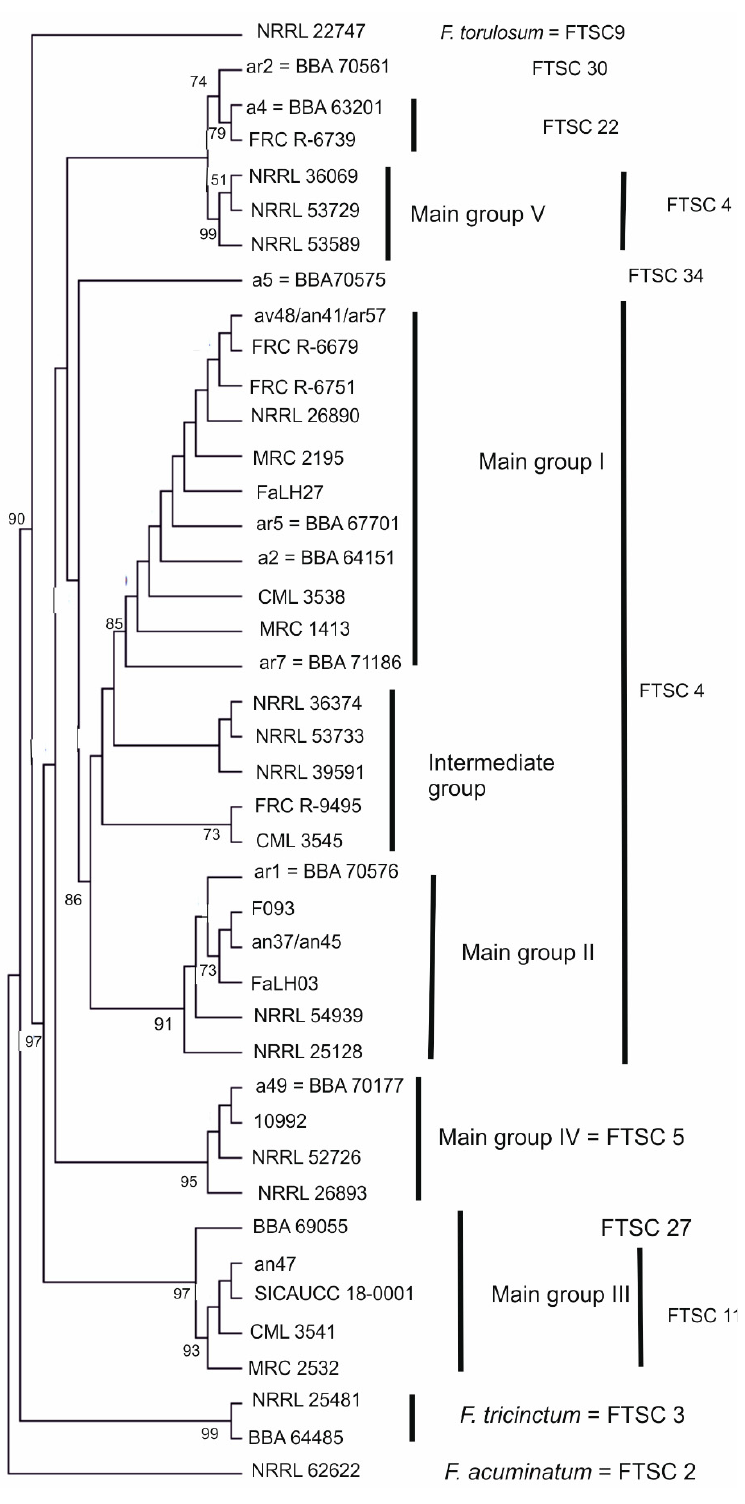
Figure 3. Maximum-parsimony consensus tree of translation elongation factor 1-alpha ( TEF1 ) se- quences, including strains from the work of Stakheev et al. [40] (2016). Bootstrap values are indi- cated above nodes based on 500 pseudoreplicates of the data. Only branches present in more than